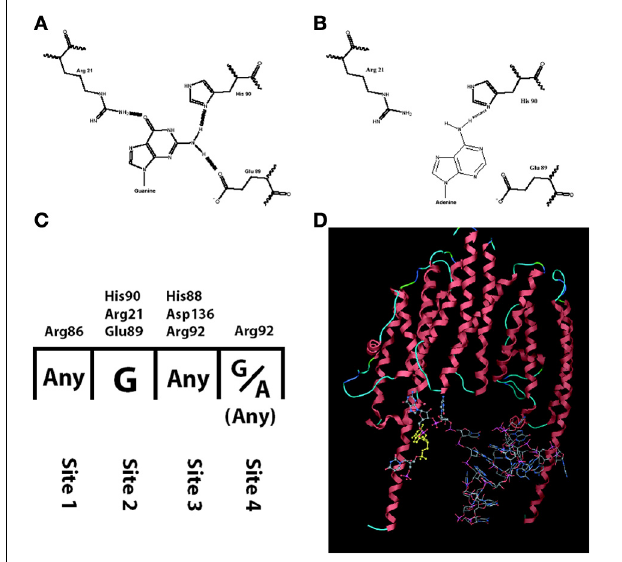
FIGURE 1 | Interaction between translin and human BDNF mRNA is hampered by the mutation G196A. (A) Translin amino acids His-90, Arg-21, Glu-89 form three hydrogen bonds with G196 (normal human BDNF) but only one with A196 (mutated BDNF, in B ). (C) The nucleotide: amino acid selectivity for each of the four binding sites on translin. (D) Three-dimensional modeling of translin dimer binding to human BDNF